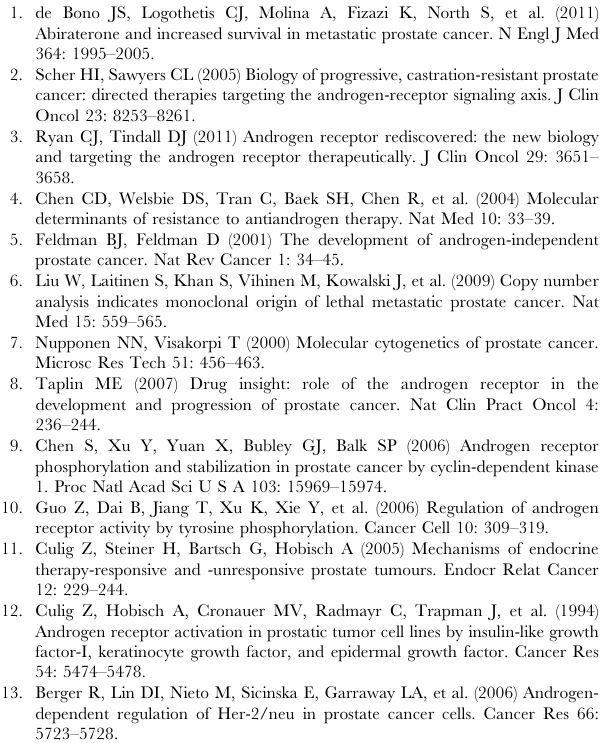
Table S2 In vivo PAC120 tumor response to different hormone treatments. Table S3 Results of the comparative genomic hybrid- ization array of DNA from androgen-independent (AI) tumors. Minimal regions were altered in more than 20% of AI variants. *Regions on 1 p, 19 p and 19 q were associated with a delayed time to hormone escape. Table S4 Characteristics of the androgen-independent (AI) variants. Data for AIde01 to AIde04 were obtained from independent experiments (data not shown). Data for mRNA expression (androgen receptor, AR) and tumoral prostate-specific antigen (PSA), circulating PSA levels and Protein expression (see last column) are relative to their mean expression in PAC120 tumors (units are